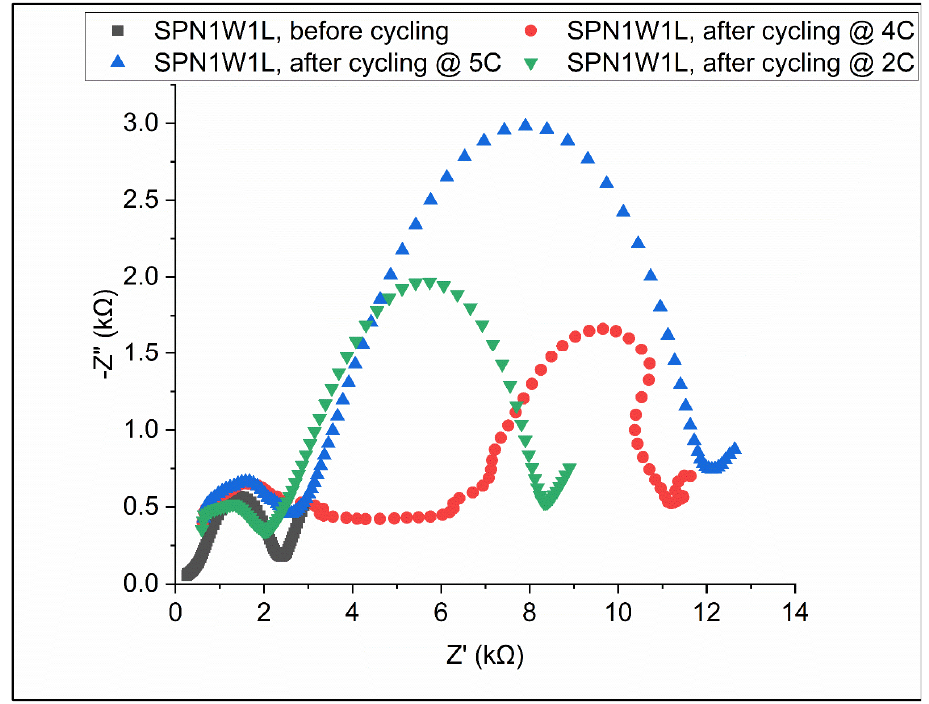
Figure 7. AC impedance spectra of the SPNWL, Ni/W = 1:1 batteries before cycling, after 100 cycles at 2C, 4C, and 5C.